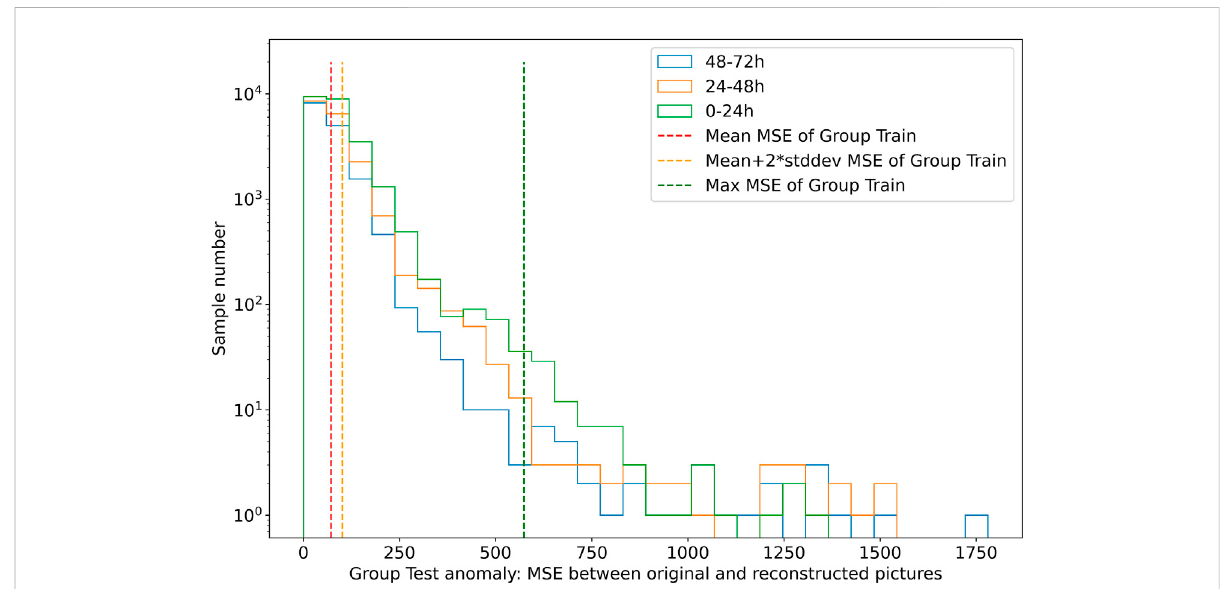
FIGURE 5 HistogramsofMSEsoftheoriginalandreconstructedpicturesinthegrouptestanomalyderivedbytheauto-encodernetwork.Thered,orange, and green histograms refer to the MSEs using subset 1 (pictures which are in the time range of (48 h , 72 h ) before strong fl ares), subset 2 (pictures which are in the time range of (24 h , 48 h ) before strong fl ares), and subset 3 (pictures which are no more than 24 h before strong fl ares), respectively. Similar to the vertical lines in Figure 4, the red, orange, and green vertical dashed lines refer to the mean value, mean + 2 × standard deviation (std: dev), and maximum of MSEs using group train,